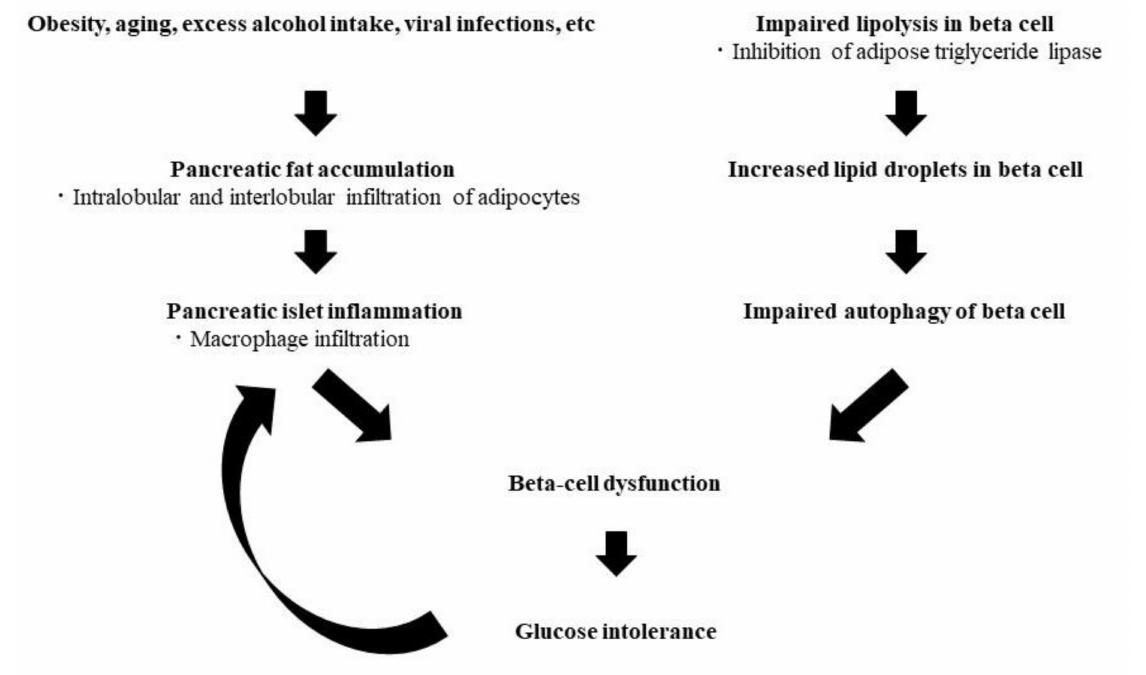
Figure 1. Hypothesis of the pathophysiology of glucose intolerance derived from ectopic fat accumulation in the